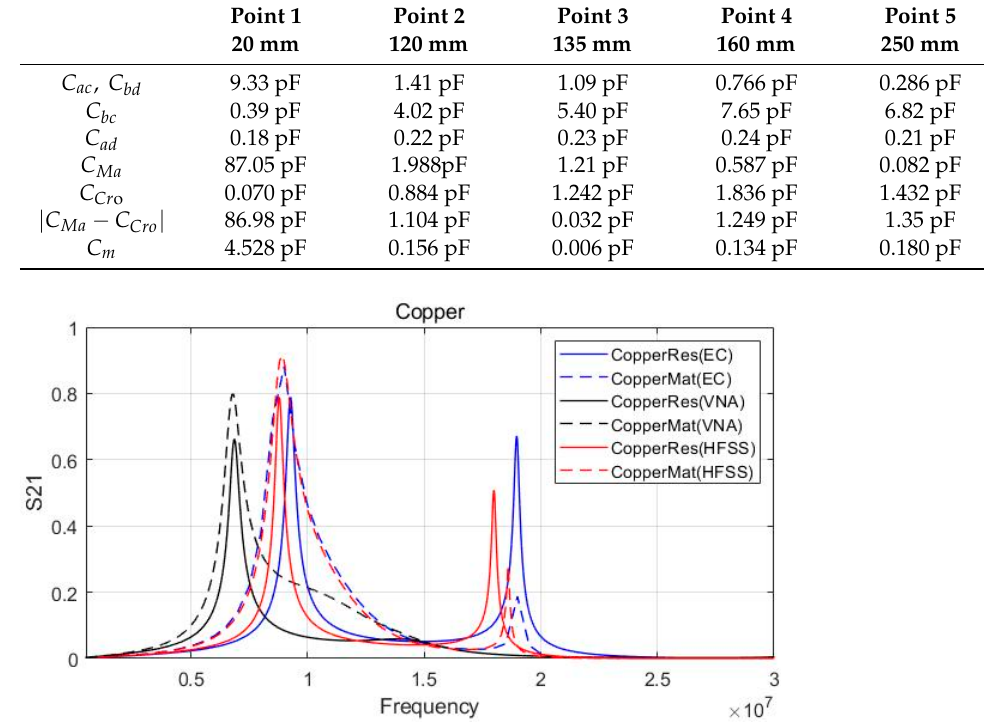
Table 3. Plate capacitance value by D y misalignment.